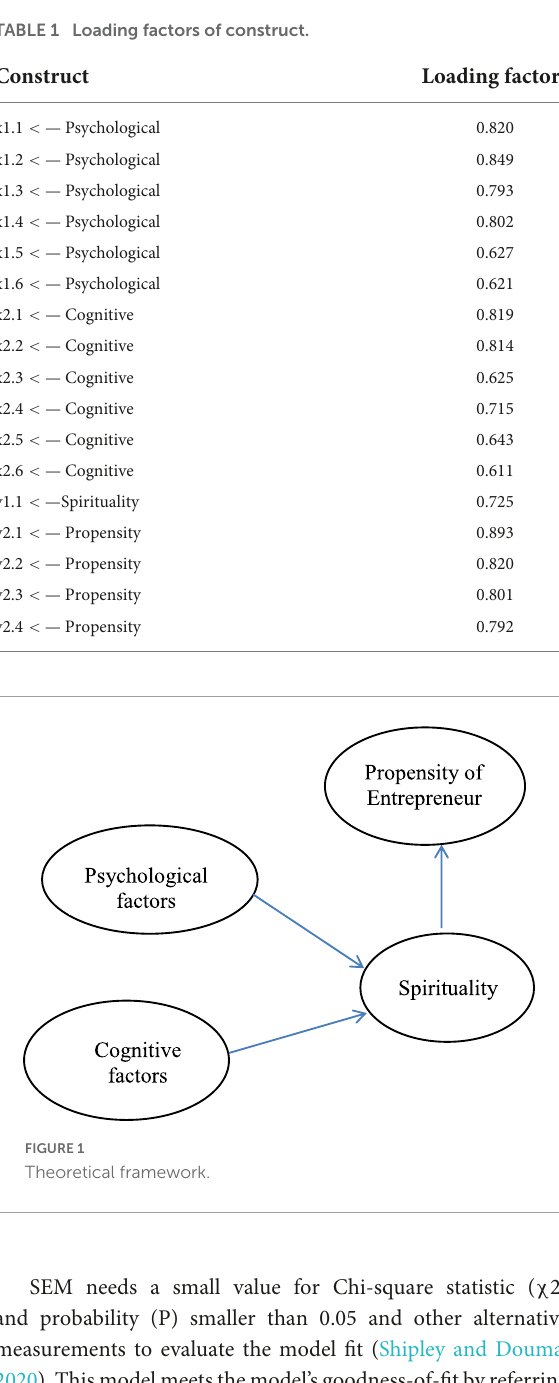
TABLE 1 Loading factors of construct.